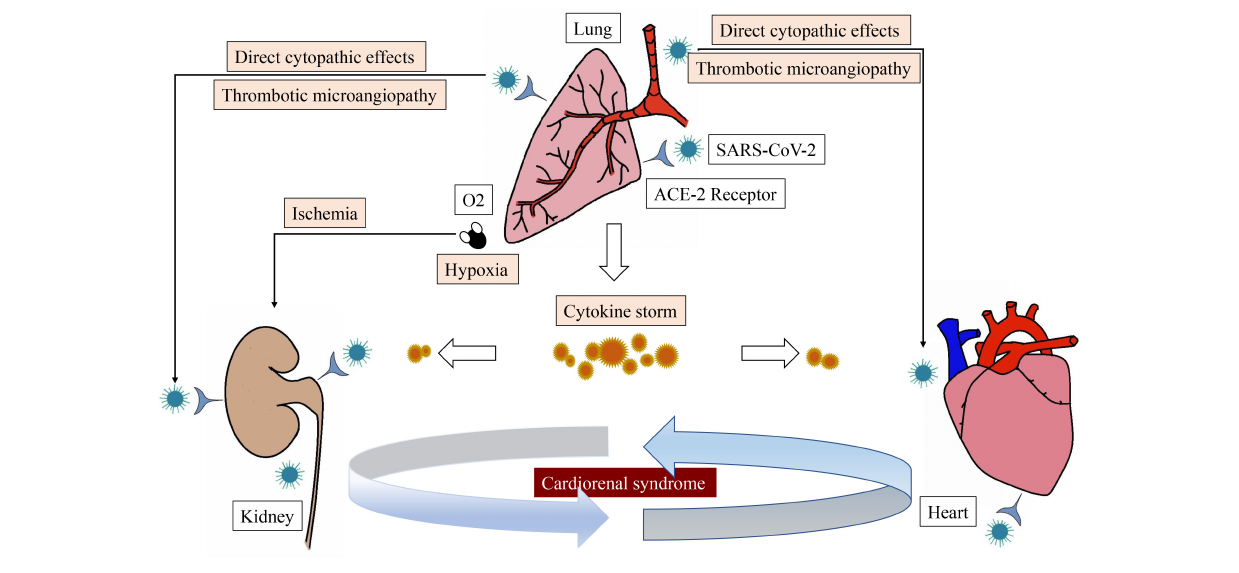
replicate and induce cytotoxicity, which may lead to organ